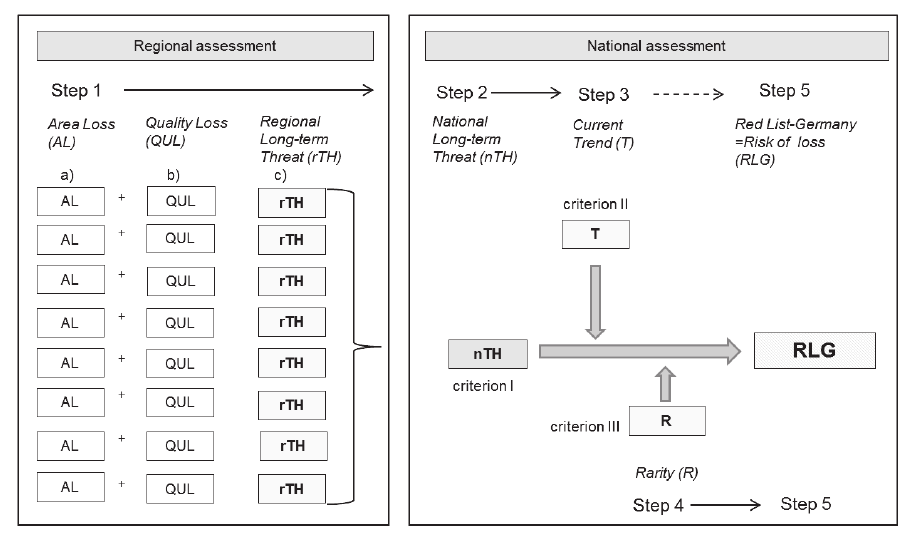
Figure 2. Stepwise Red List assessment for habitat types in Germany. The ‘National Long-term Threat’ (nTH) is derived from the ‘Regional Long-term Threats’ (rTH) of eight major landscape regions (Step 1, 2) (see Fig. 3). After that, the degree of endangerment is upgraded or devalued consecutively, first by applying criterion T (Step 3) and then criterion R (Step 4). RLG represents the overall ‘Risk of loss’ (Step 5) (cf. BfN